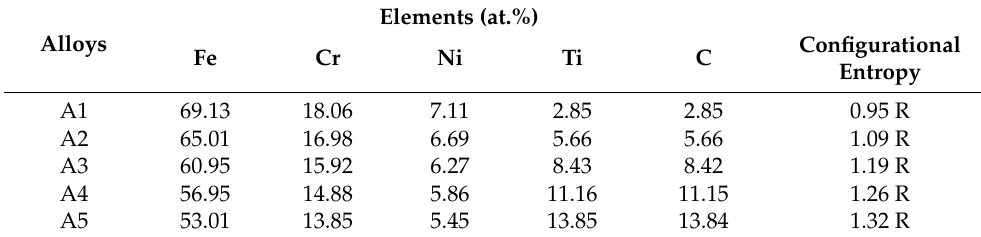
Table 1. Chemical composition of designed alloys in atomic percent. Elements (at.%) Alloys Fe